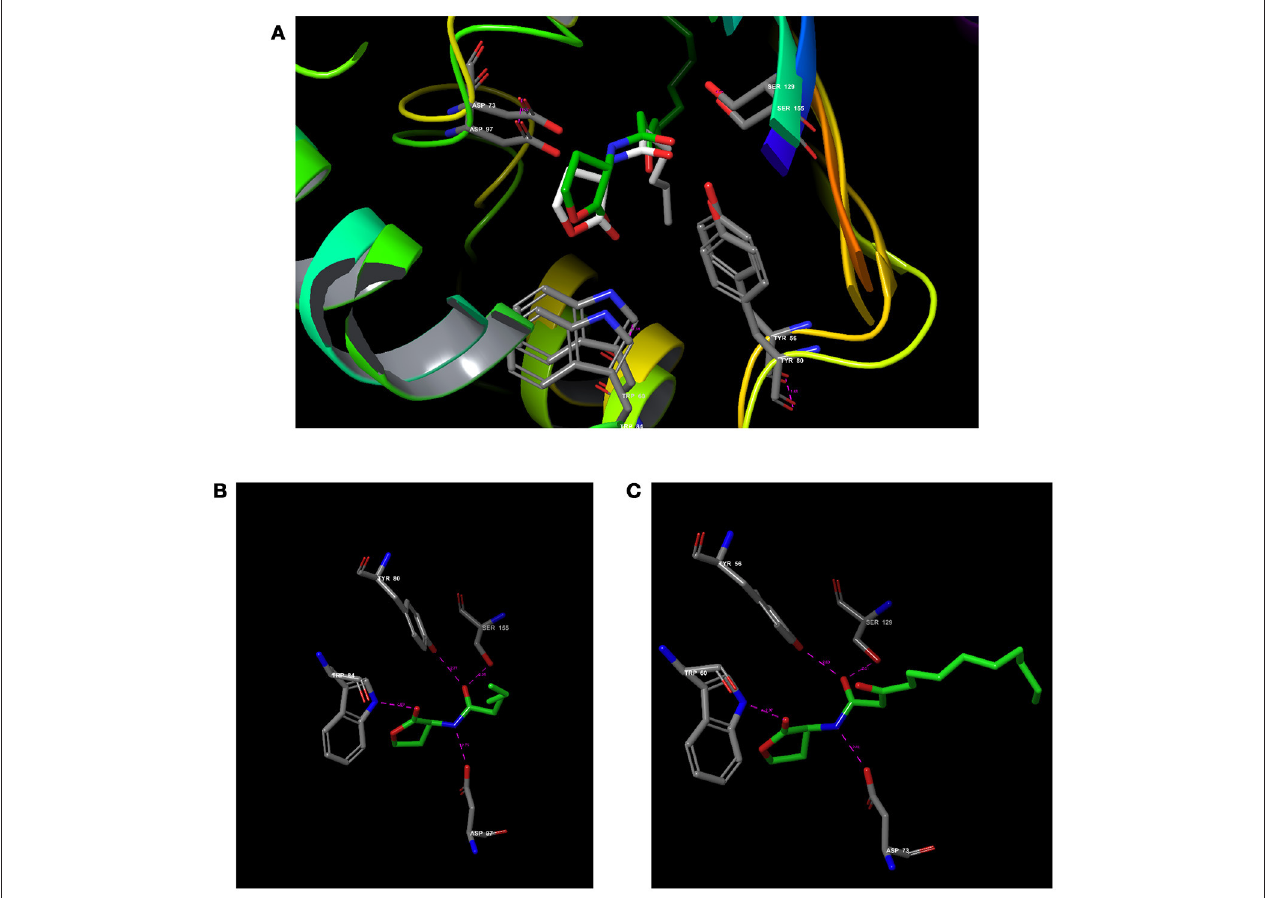
FIGURE 3 | Comparative analysis of CviR with LasR using RCSB PDB Protein Comparison Tool. (A) Molecular comparison of CviR vs LasR. (A) The alignment of the active site residues (Tyr, Trp, Asp, Ser) which are crucial for the interactions. (B) The molecular interaction of (N-hexanoyl-L-Homoserine lactone (C 6 HSL) against CviR (C) The molecular interaction of N-(3-Oxododecanoyl)-L-homoserine lactone (3-Oxo-C 12 -HSL) with LasR.